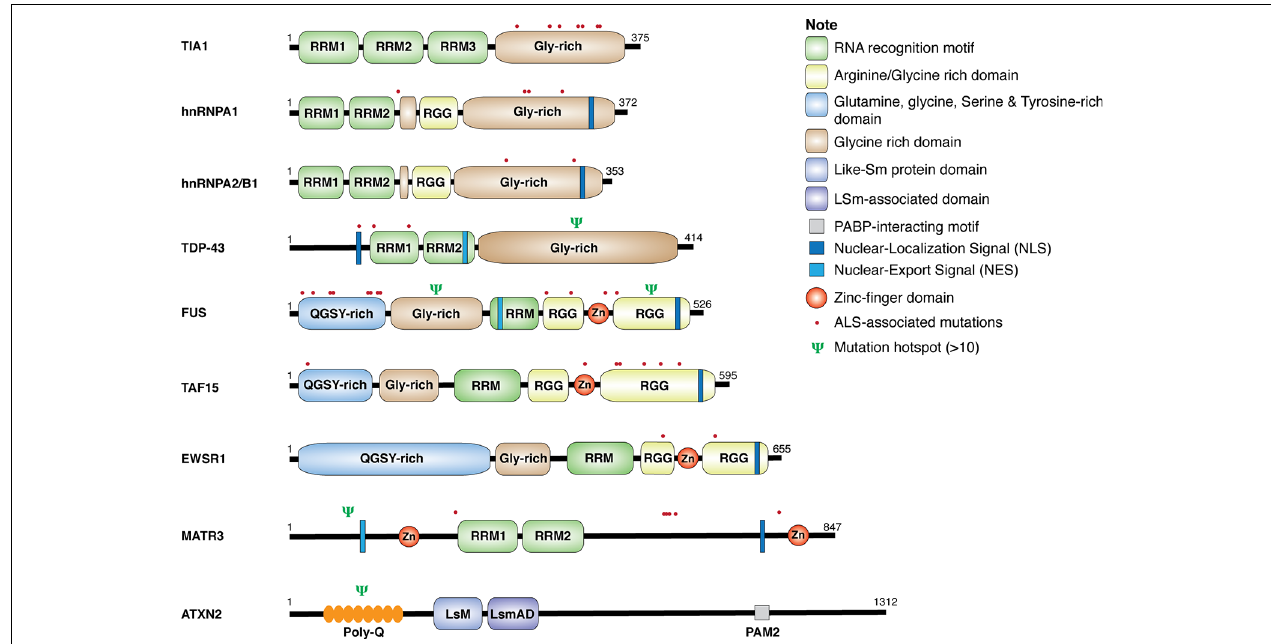
FIGURE 1 | Structure and mutations in RNA-binding proteins (RBPs). Schematic diagram for amyotrophic lateral sclerosis (ALS)-associated RBPs. The location of single point mutations for each RBP is indicated as red dot, and the psi symbol denotes the location of multiple mutations associated with ALS-related motor neuron